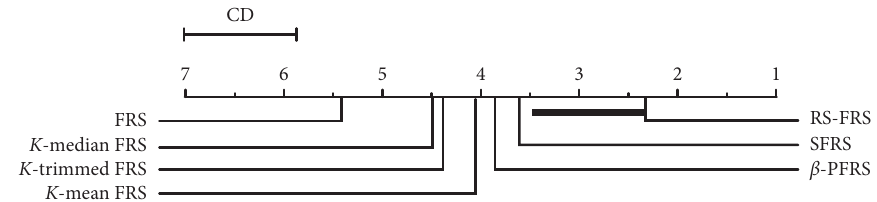
Figure 4: CD diagram of different FRS models on KNN based on Bonferroni-Dunn statistical method.